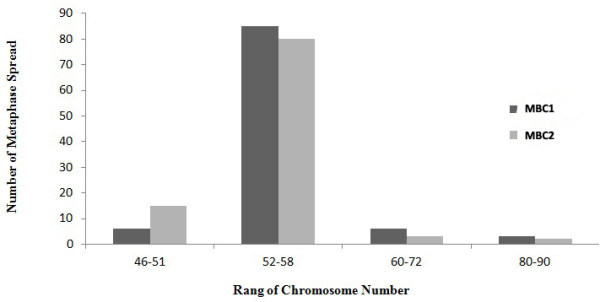
Chromosomal Distribution Pattern of the MBC1 and MBC2 Cell Lines in 100 Metaphase Spreads. A high percentage of the metaphase spreads showed chromosome numbers ranging from 52–58 in both MBC1 and MBC2 cell lines.